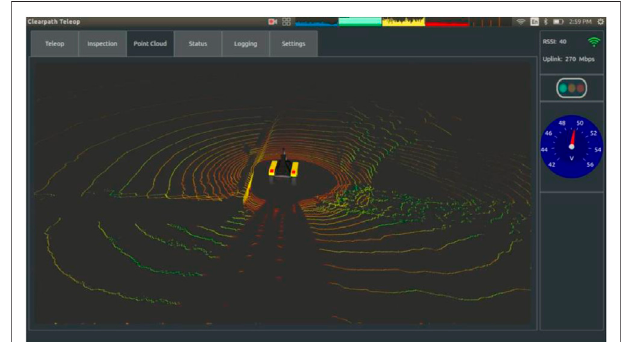
FIGURE 2 | A teleoperation interface from Clearpath Robotics. This tablet interface contains numerous sensor data streams which are accessed through mode switching via the top buttons in a tab-like interface. This interfacereducesinformationloadfortheoperator,butmakesaccessing all information quickly more dif fi cult due to the need to switch tabs (source: Clearpath Robotics).